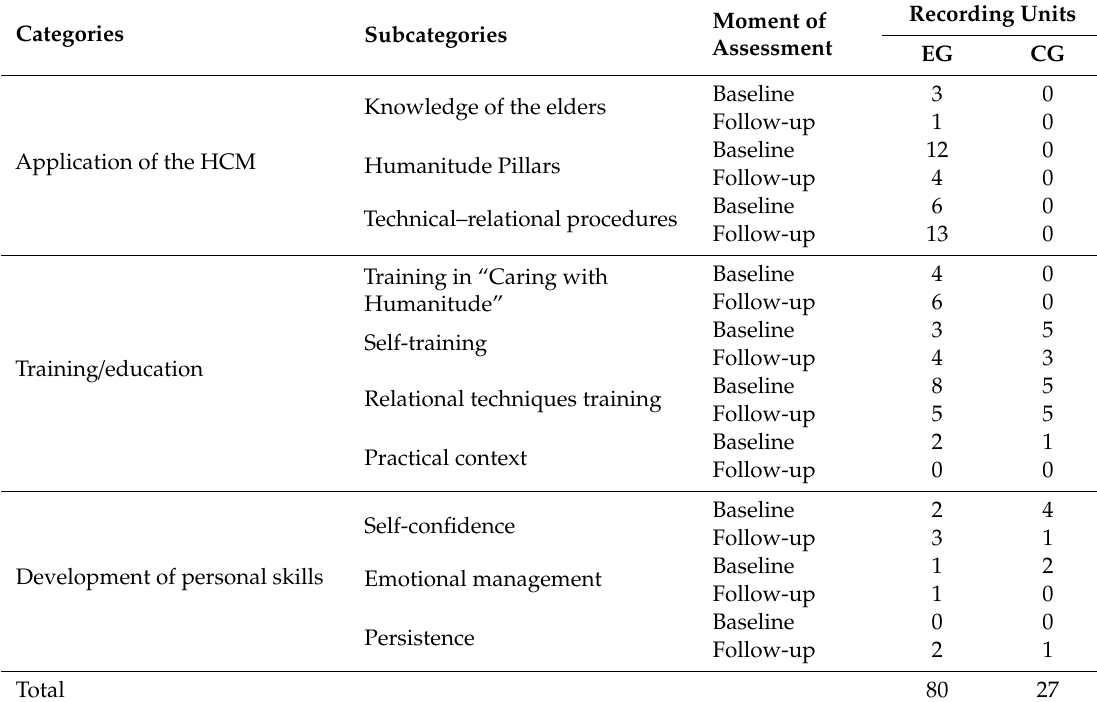
Recording Units Moment of Assessment